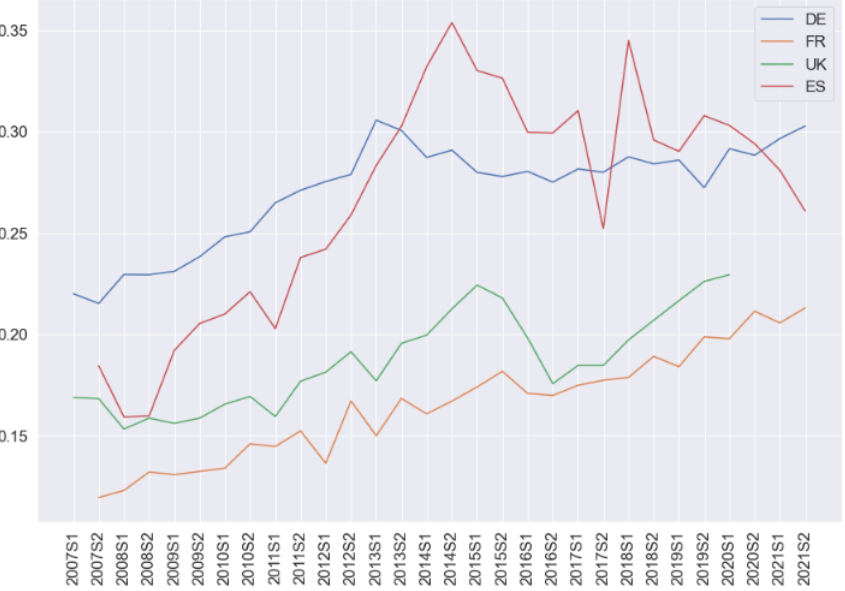
Figure 7 : Non-household electricity prices including taxes and levies in the lowest consumption band in selected countries. Source dataset: Eurostat: NRG_IND_REN. band in selected countries. Source dataset: Eurostat: